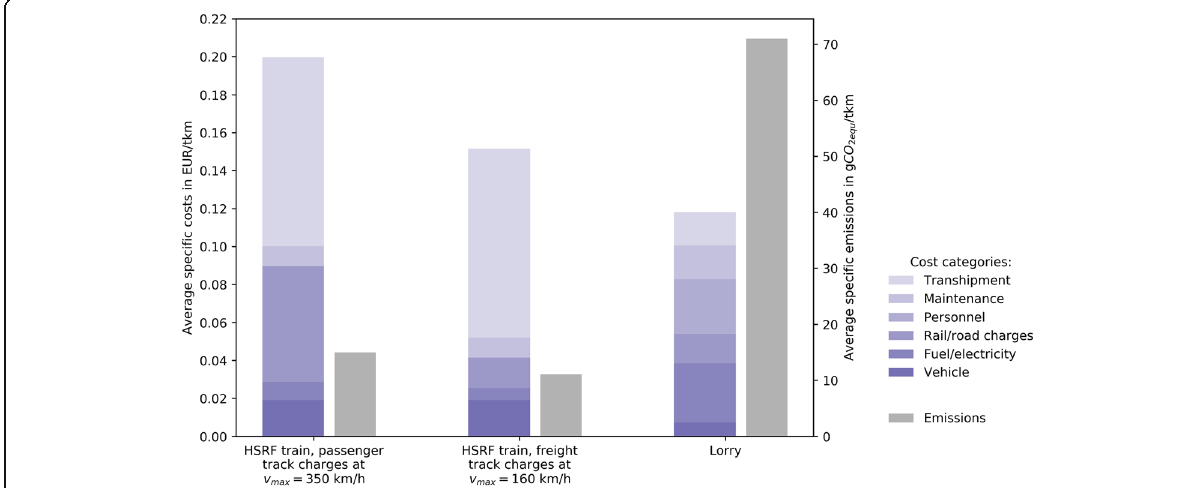
Fig. 3 Specific costs and emissions of the HSRF concept compared to road